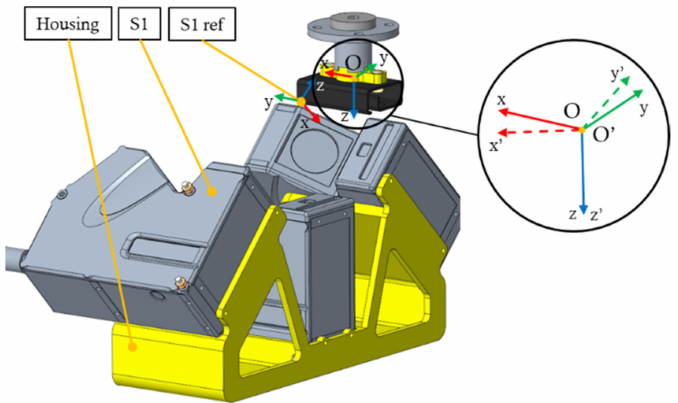
Figure 4. Scanning of Object B. The figure detail shows the coordinate systems O (the object is not oriented) and O’ (the object is oriented at a yaw angle of − 2 ◦ ). The scanning direction is always in the x-axis direction of the O coordinate